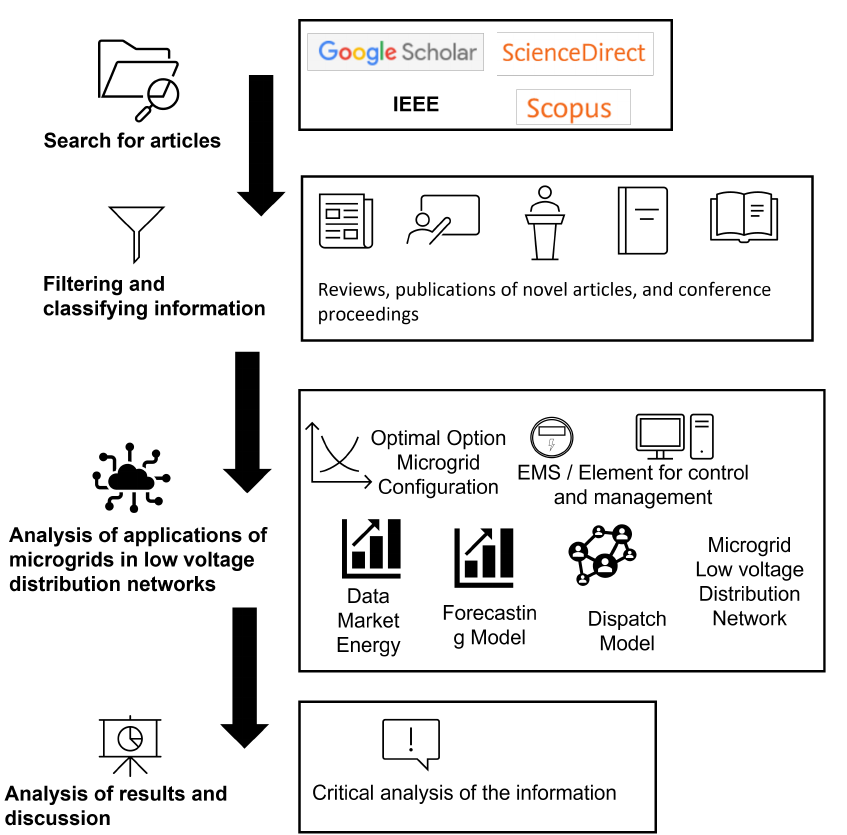
Figure 1. Proposed methodology, general